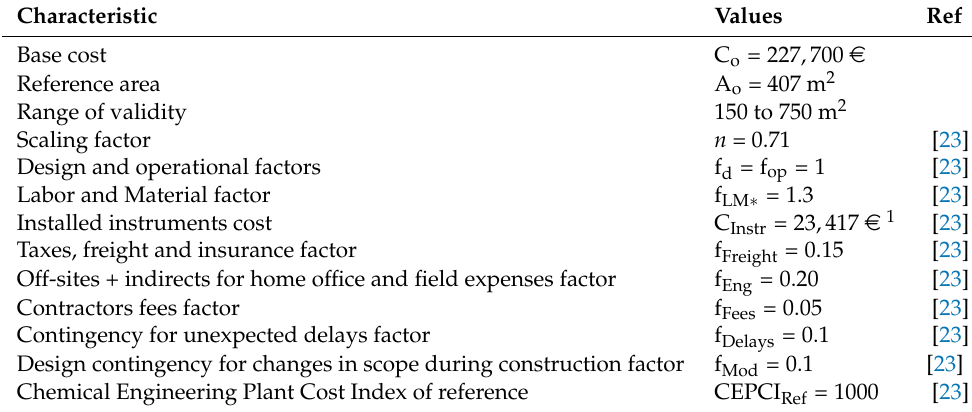
Table 1. A summary of the different parameters of the Bare Module (BM) model proposed by Reference [23]. The correction factors and installed instruments costs are taken from Reference [23], while the base cost is adjusted in order to minimize the least squares error between the model and the data retrieved from the